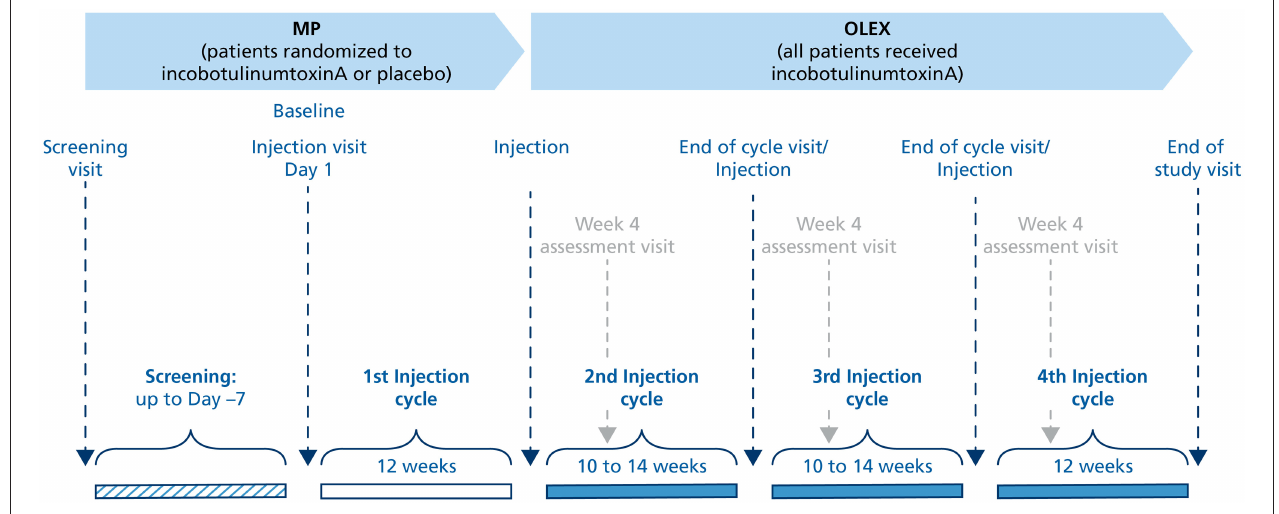
FIGURE 1 | Study design. MP, main period; OLEX, open-label extension